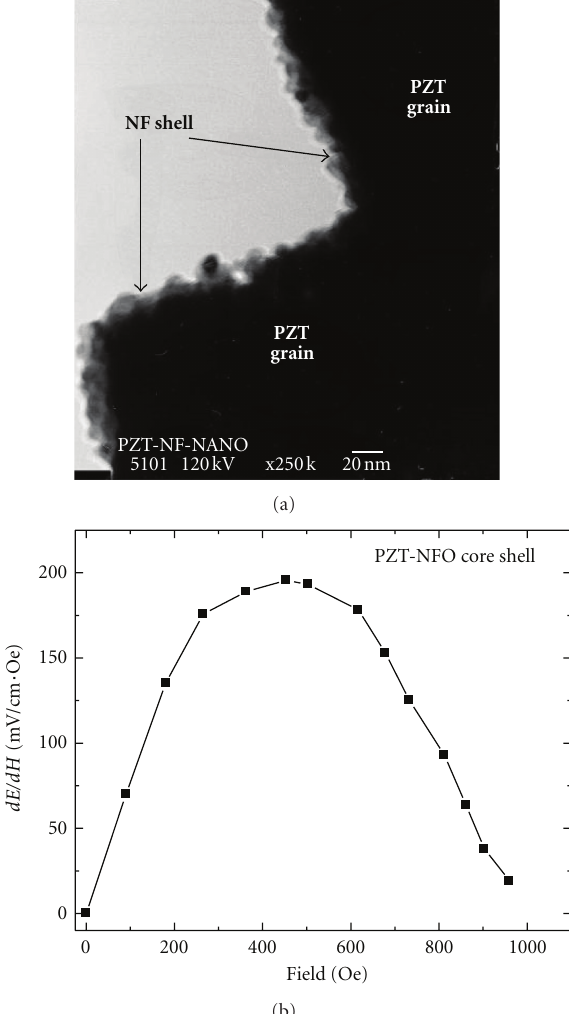
Figure 28: TEM image of sintered core-shell structure, (b) mag- netoelectric coe ffi cient as a function of DC bias field for sintered PZT-NF core shell structure.